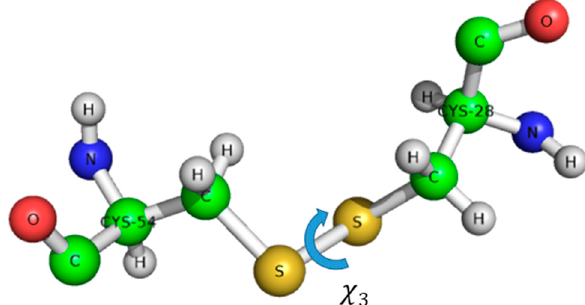
Figure 1. Definition of χ 3 dihedral angle on the example of Penicillium chrysogenum antifungal protein 112 (PAF) Cys28-Cys54 disulfide